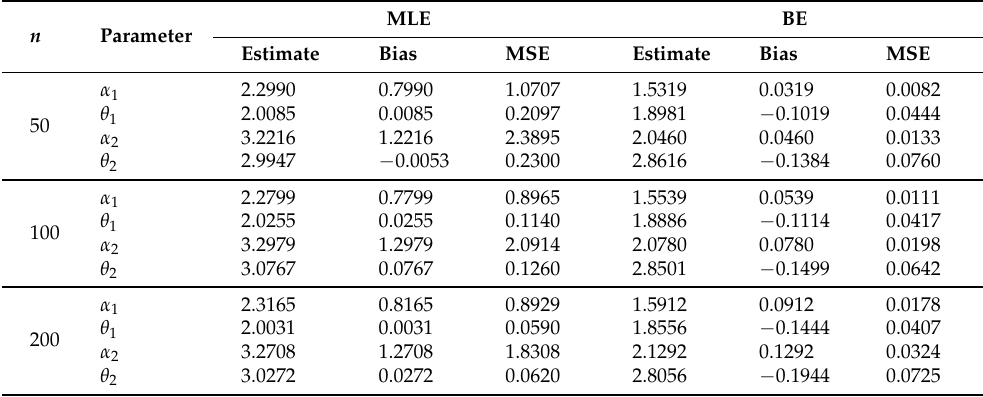
Table 2. Point estimates of ( α t , θ t ) , t = 1,2 under Scheme 2.